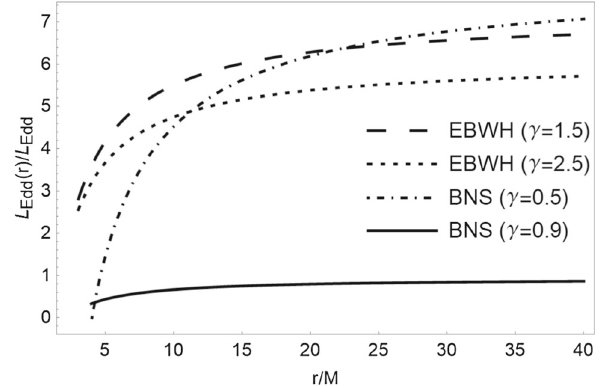
Fig. 9 Profile of the EBWH differential luminosity reaching an observer at infinity, ( rd L ∞ / dr )/ ˙ M 0 , for different γ